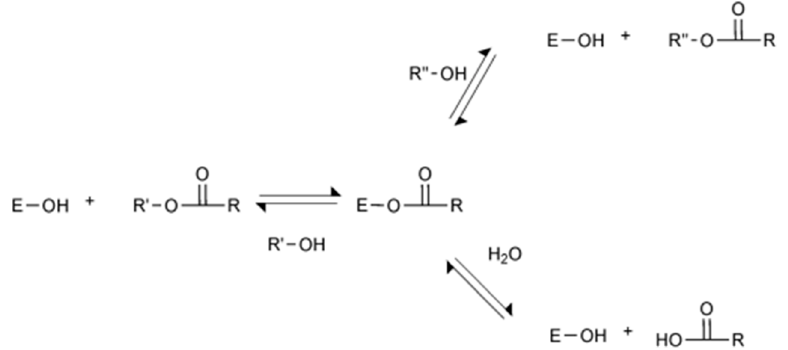
Figure 1. Lipase-catalyzed reactions.